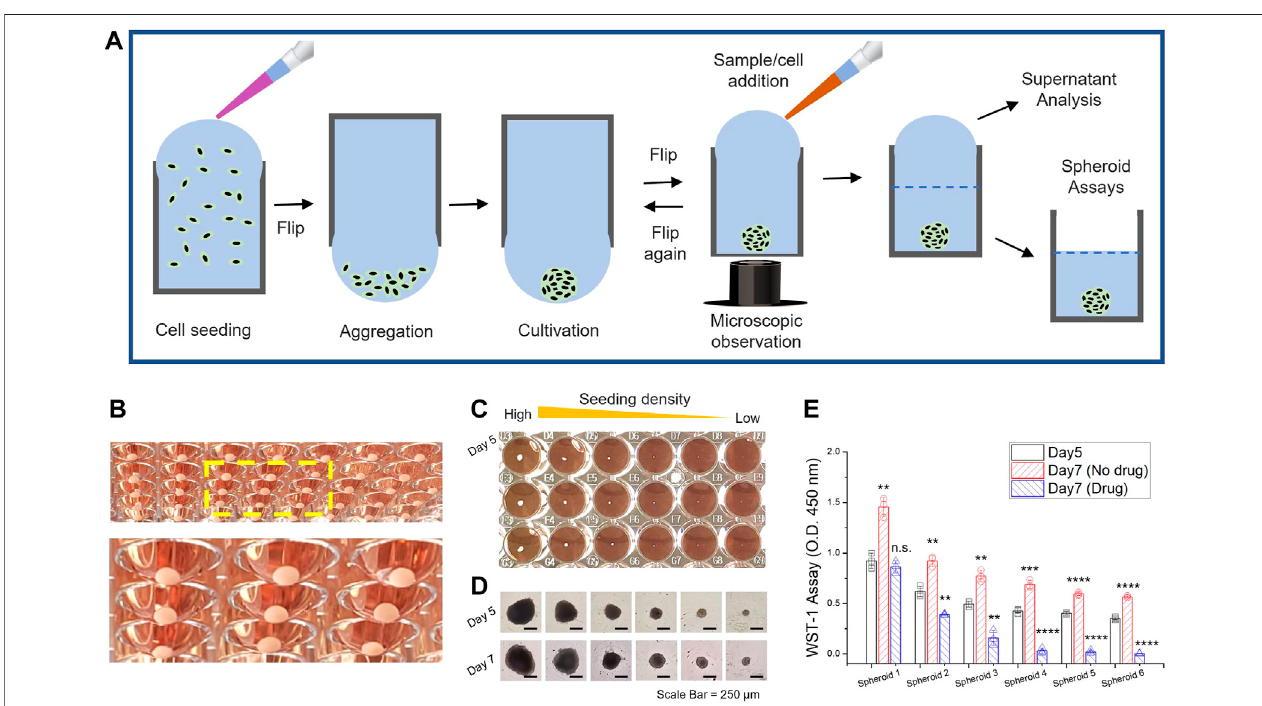
FIGURE 2 | 3D spheroid generation through well-plate fl ip. (A) Schematic work fl ow of tumor spheroid generation and sample management for endpoint analysis. (B) Large 3D spheroid of HCT116 cells, uniformly generated at the bottom of the fl ipped hanging drop in a standard 96-well plate. The 3D spheroids were cultivated for 2 weeks with manual replacement of culture media. The yellow dash box indicates a magni fi ed view of the spheroids in hanging drop formation (C) 3D spheroid generationwithdifferentseedingconcentrationsofHCT-116 cells (D) .Microscopeimages aftercultivation for5and7 days.Scalebar =250 μ m. (E) WST-1 assay to assess 3D spheroid proliferation in Day 5 and Day 7; Nondrug treatment and drug treatment of 5-azacytidine (0.5 μ M). Data represent mean ± SD ( n = 3, biological replicates per condition, * p < 0.05; ** p < 0.01; *** p < 0.001 and **** p < 0.0001 Signi fi cance byStudent ’ s t -test.).The results were statistically compared with the groups (on Day 5) . (C – E) The initial seeding density of HCT116 cells was from 2 × 10 4 (Spheroid 1) to 3 × 10 2 (Spheroid 6) cells per well (a two-fold decrease in each